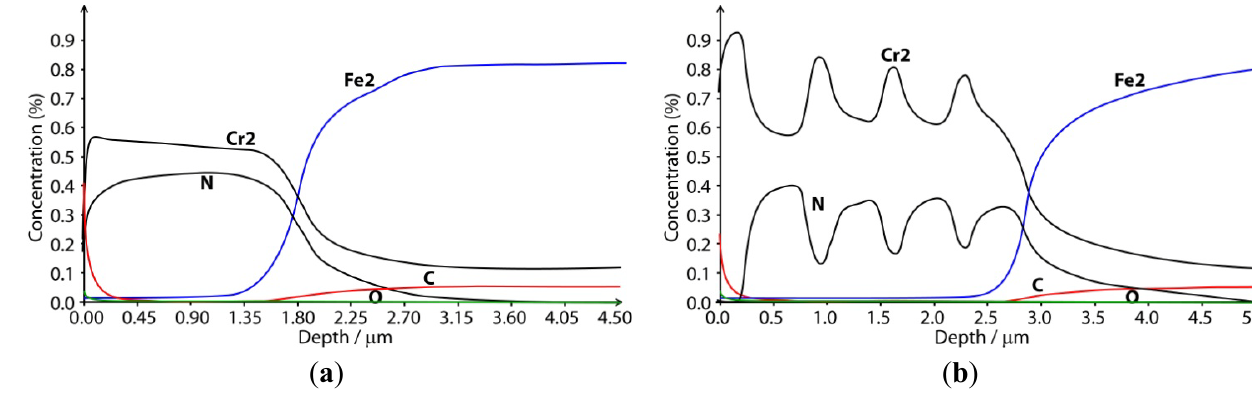
Figure 4. Glow discharge optical emission spectrometry (GDOES) spectra of coating